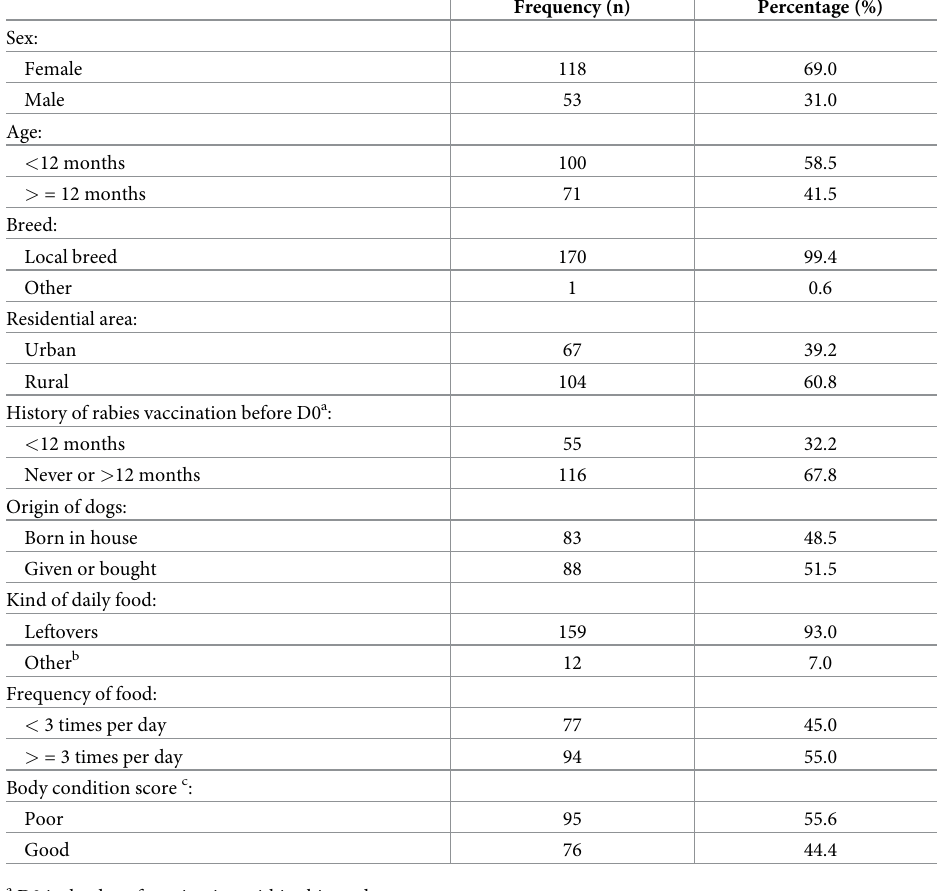
Table 1. Demographic characteristics of dog surveyed in Flores Island, Indonesia at day 30 after vaccination (n =